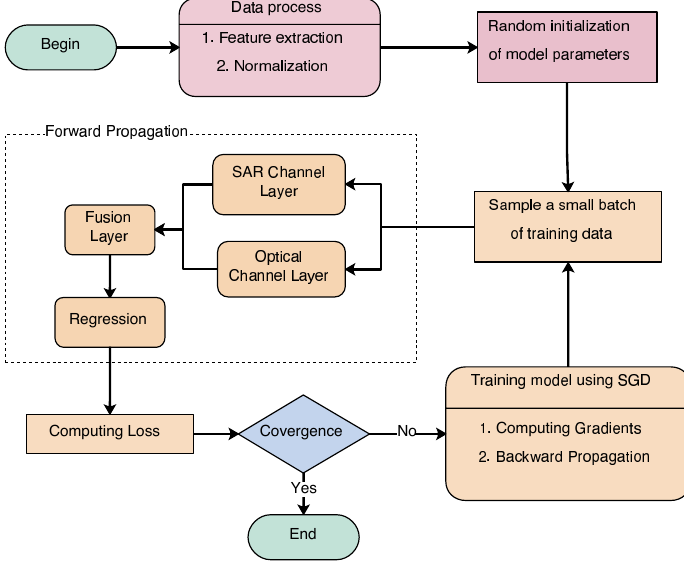
Figure 3. GSDNN architecture for maize LAI and biomass